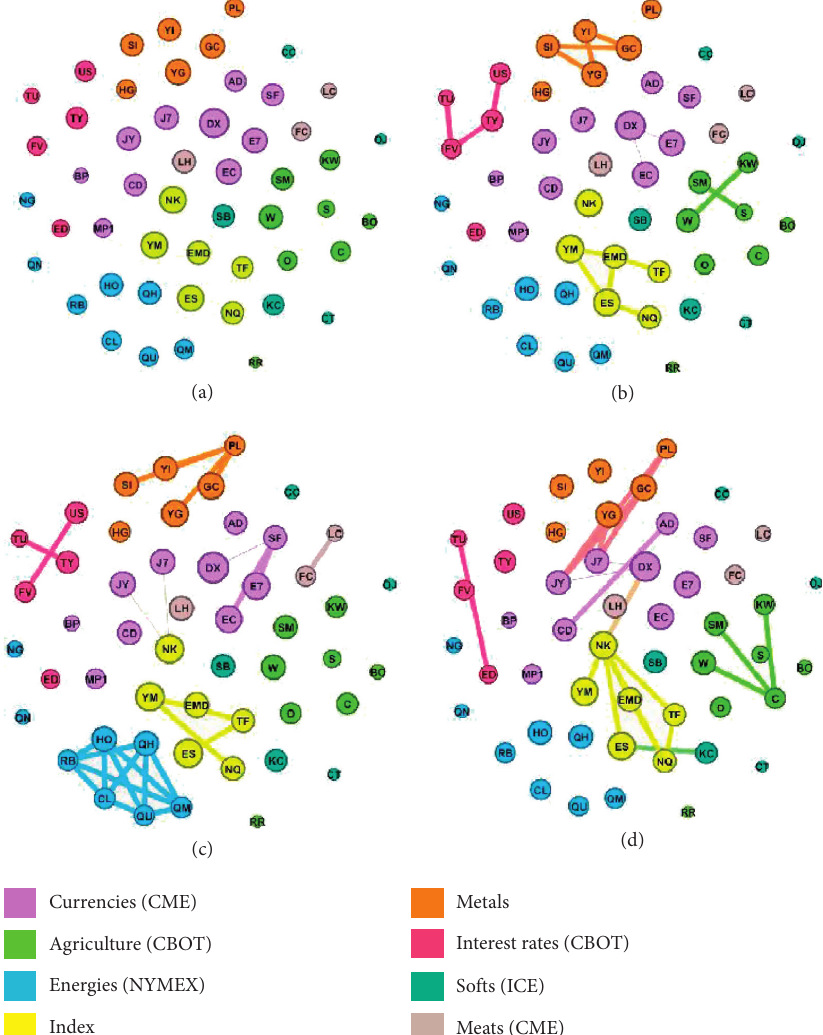
Figure 1: The global market sectors and correlation groups in the 2013–2017 daily close value. (a) All 51 futures instruments in the global market and the sectors belong to those instruments. (b) The highly correlated instruments group ( σ < − 0.75 and 0.75 < σ ). (c) The moderately correlated instruments group ( − 0.75 < σ < − 0.5 and 0.5 < σ < 0.75). (d) The low correlated group ( − 0.5 < σ < − 0.25 and 0.25 < σ <